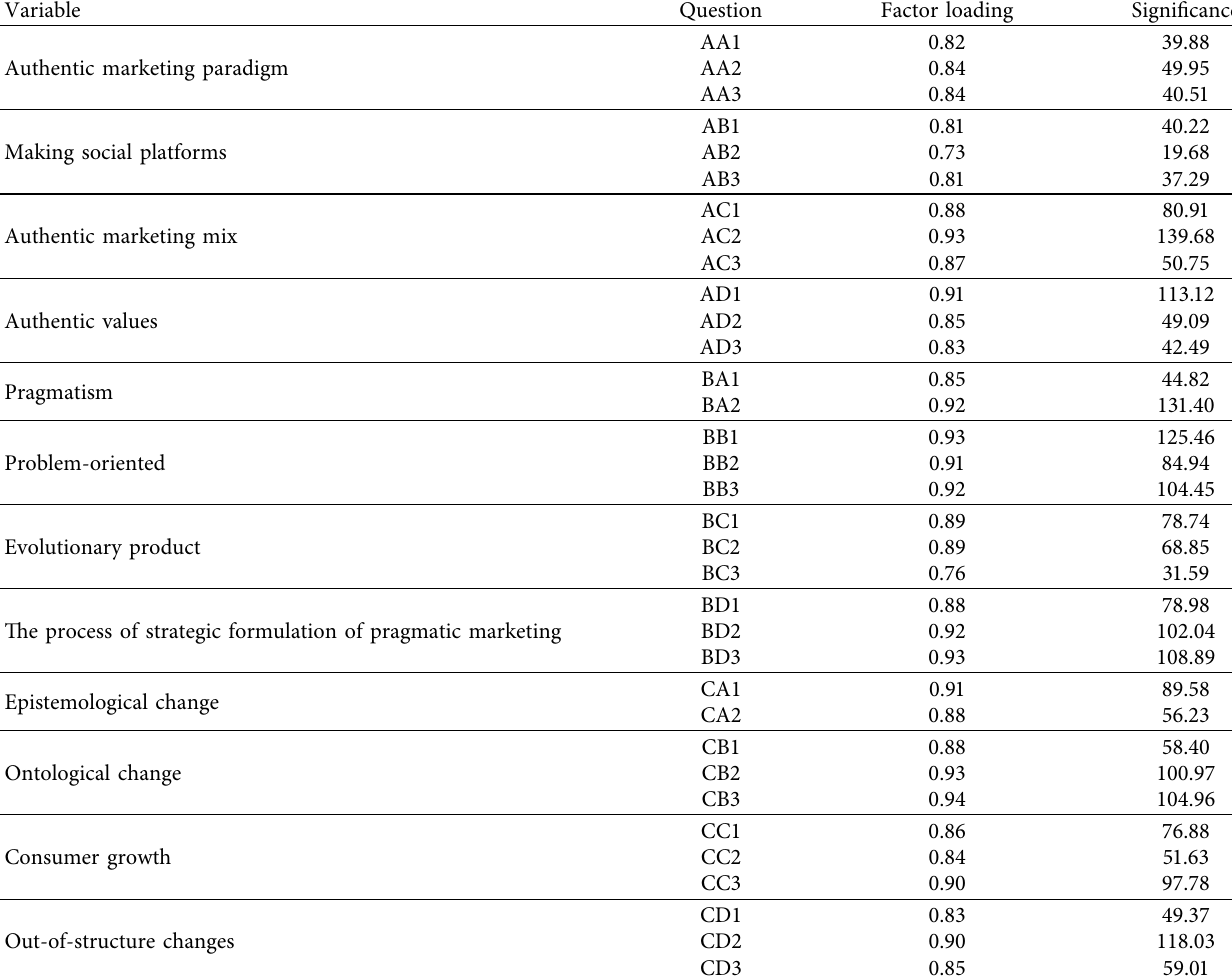
Table 4: Factor loading and significance of questions (second-order